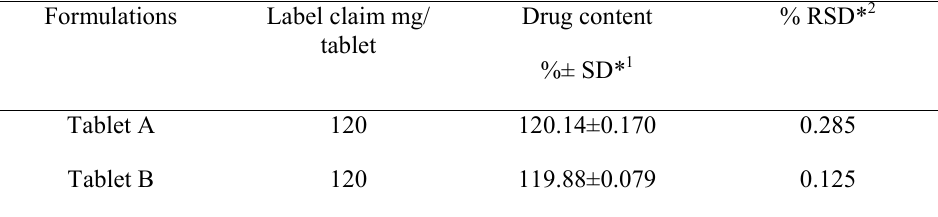
Table 5. Assay results of tablet dosage form using proposed